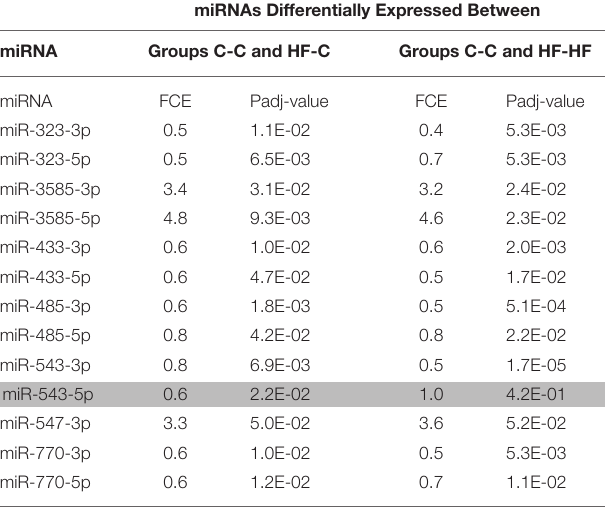
TABLE 4 | miRNA expression in groups HF-C and